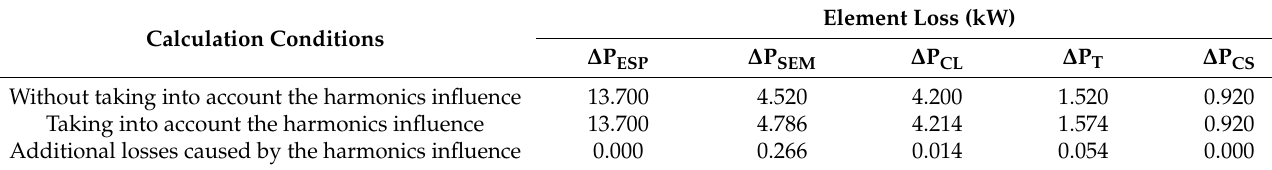
Table 5. Structure of power losses in ESP ETC